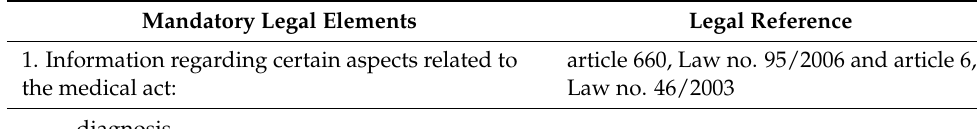
Table 1. Mandatory legal elements of patient’s informed consent.